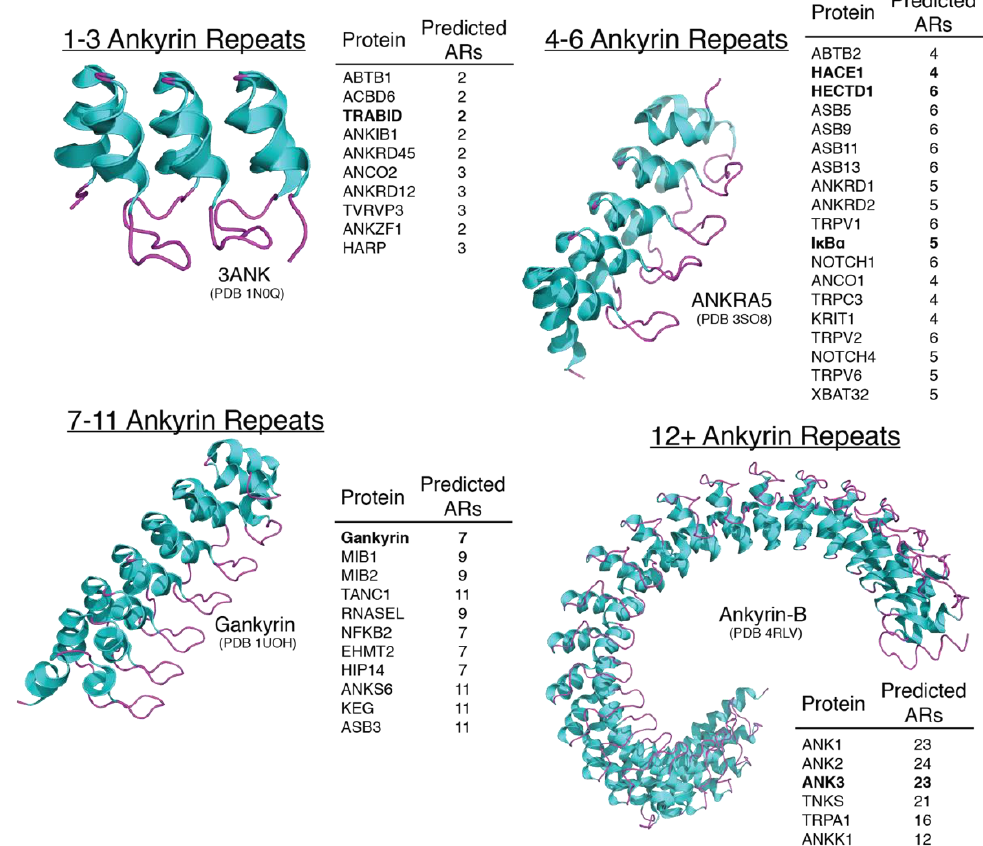
Figure 2. Examples of AR domain-containing proteins based on AR repeat number. AR domains can contain a wide variety of repeats, but predominately contain four to six. With each repeat, the 90 ◦ and L-shape formation becomes more prevalent resulting in a 3D revolving twist. In general, with each additional AR repeat, there is a correlation between complexity of the AR-containing protein’s biological role in cellular processes that it regulates. This may be due to the increased number in substrate binding pockets available that could be recognized by the substrate. The AR domain-containing proteins discussed in this review are highlighted in bold.